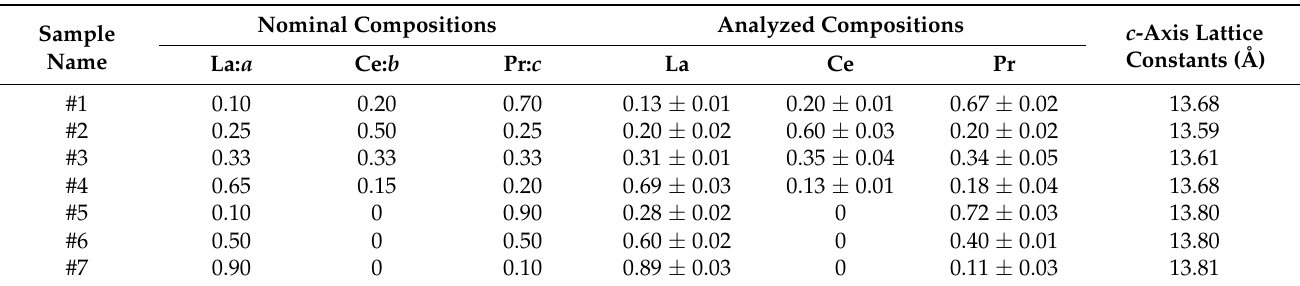
Table 1. Nominal compositions and analyzed compositions at the R -site, and c -axis lattice constants in the grown single